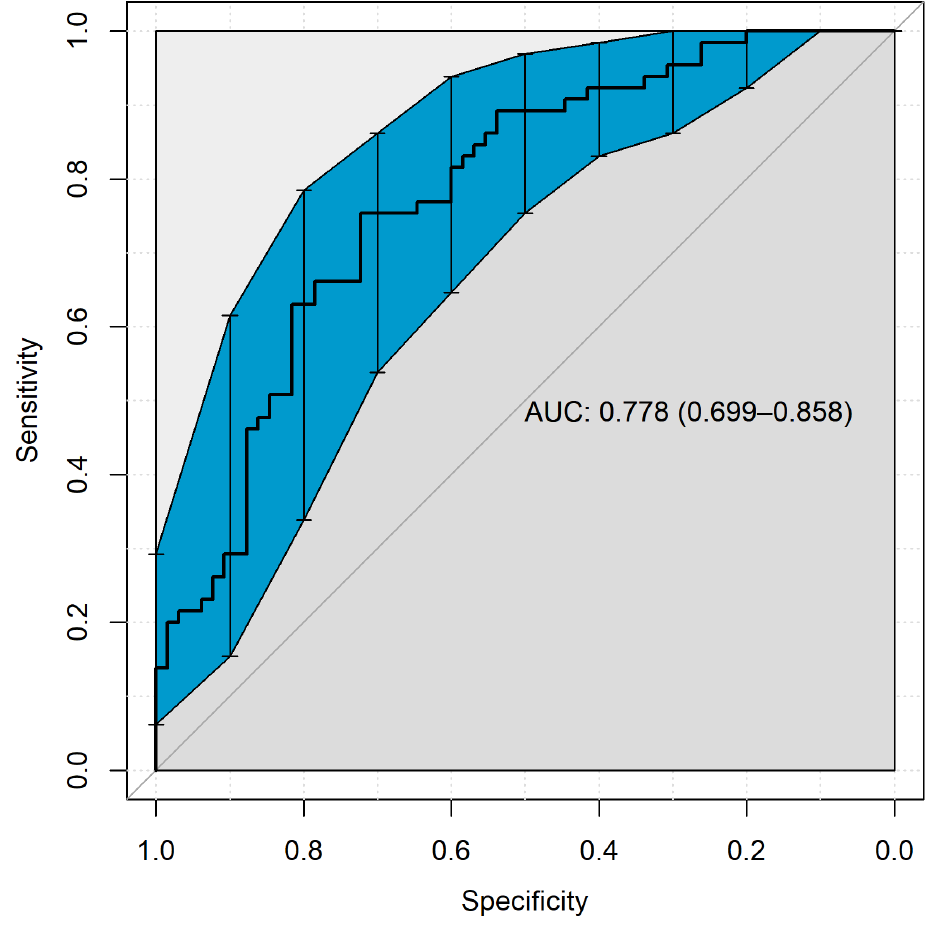
Figure 3. Receiver operating characteristic plot. The area in blue corresponds with 90% confidence intervals.